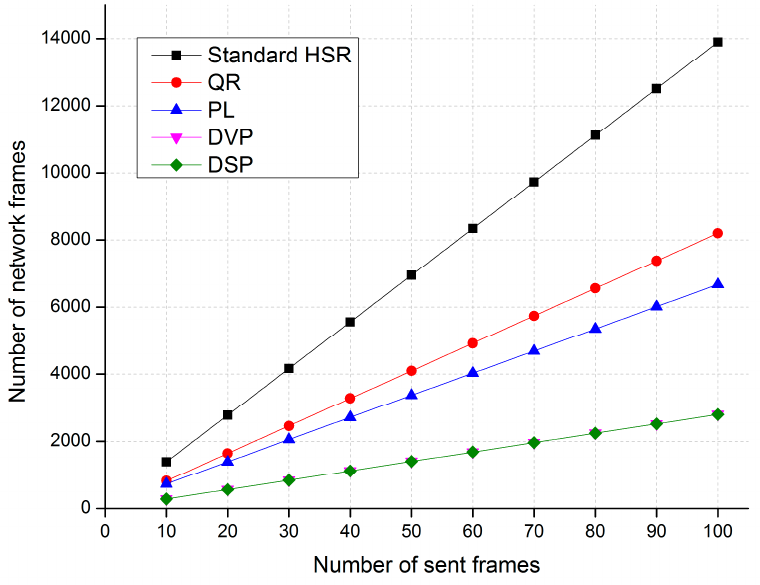
Figure 13. A comparison of traffic performance in Case 3.